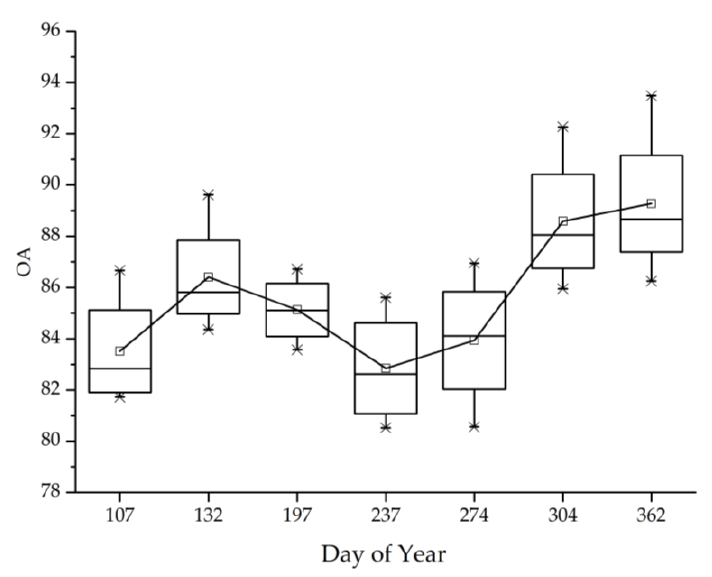
Figure 12. The relationship between classification performance and time-series data. The horizontal axis represents the time-series data combination from the seventeenth day to the indicated time.